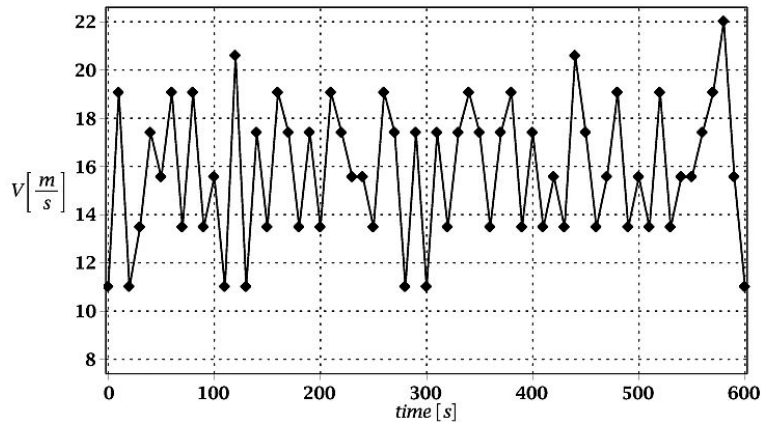
Figure 2. Dynamic wind